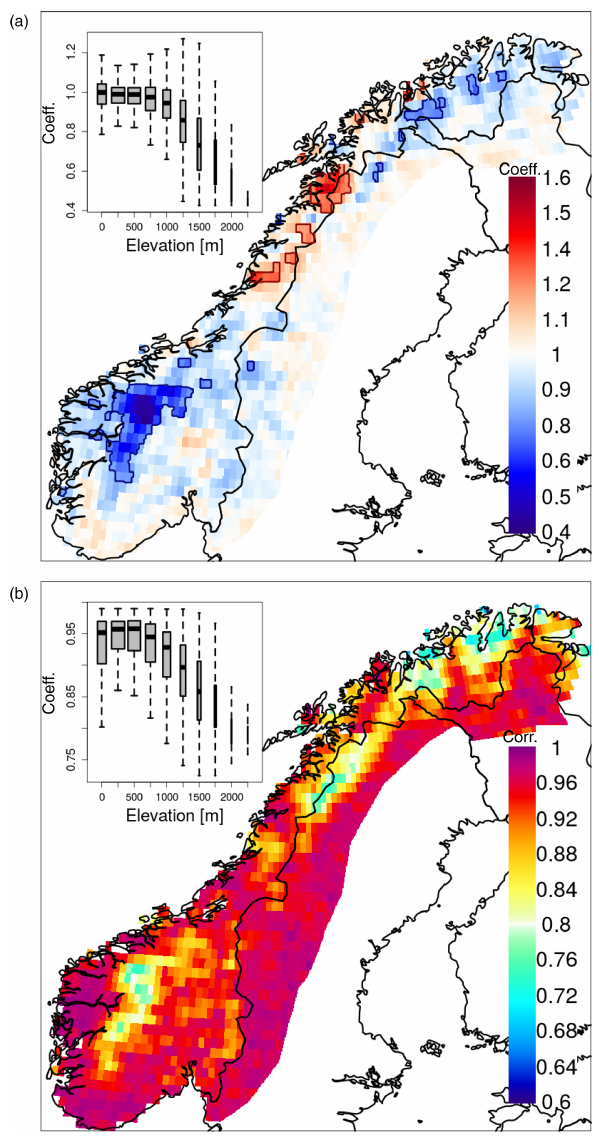
Figure 4. Daily precipitation comparison between E-OBS and seNorge2, which has been upscaled to the E-OBS grid (0 . 25 ◦ × 0 . 25 ◦ geographical latitude–longitude coordinate reference sys- tem). (a) Fitted linear regression coefficient, seNorge2 = coeff · EOBS; regions where the coefficient values are smaller than 0 . 8 or larger than 1 . 2 are highlighted by thick contouring lines. (b) Corre- lation coefficient. The two insets in the top-left corners in the panels show the elevation dependence of the corresponding variable; note that the box width is proportional to the number of points in the elevation